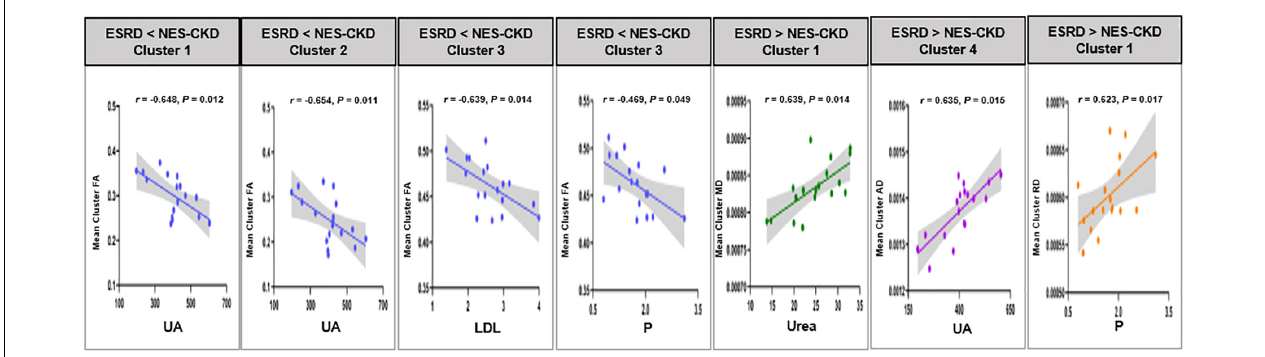
FIGURE 5 | Relationship between mean cluster diffusion metrics and biochemical tests. UA, uric acid; LDH, low-density lipoprotein; P, serum phosphorus; Urea, serum urea. ESRD, end-stage renal disease; NES-CKD, non-end-stage chronic kidney disease; FA, fractional anisotropy; MD, mean diffusivity; AD, axial diffusivity; RD, radial